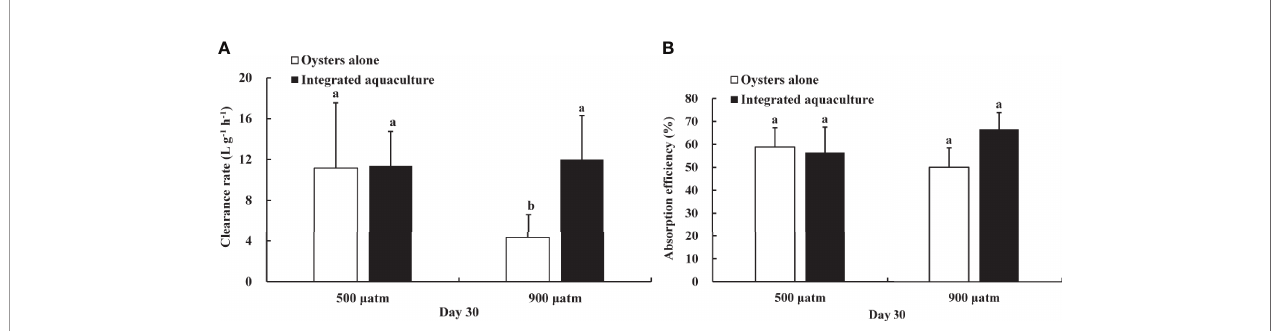
FIGURE 4 | Clearance rate (A) and absorption ef fi ciency (B) of C . gigas exposed to different treatments for 30 days. Means ± SD are shown. Different letters indicate signi fi cant variation between treatments ( P < 0.05).